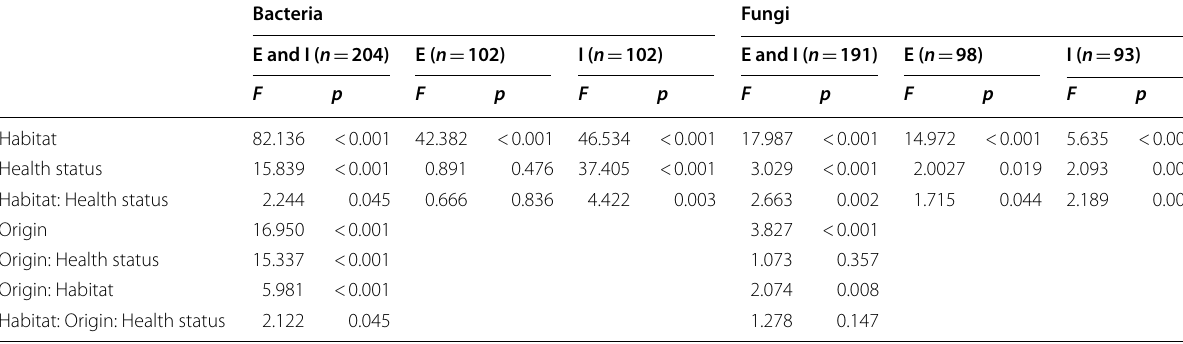
Table 1 Results of PERMANOVA on bacterial and fungal community compositions (caterpillars only) a